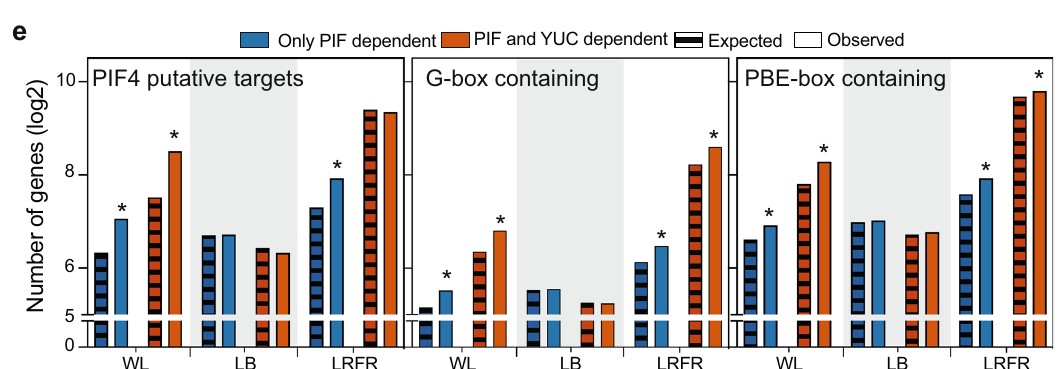
Fig. 3 | PIFs & YUCs are required for basal expression of many growth- and hormone-associated genes in hypocotyls of WL-grown seedlings. a The dis- tribution of LB-induced genes in hypocotyls according to the dependence on PIFs and YUCs using the comparison of Col-0, pif457, and yuc2589 transcriptomes (FDR<0.05, F test with post hoc test). b Distributions of Z-scores computed from replicate averages for categories shown in ( a ). c Number of misregulated genes in pif457 and yuc2589 hypocotylscomparedtoCol-0inWL(FDR<0.05, T testwithBH correction). d Distributions of Z-scores computed from replicates averages for genes that are grouped as in ( c ). e Comparison of PIF-dependent genes in